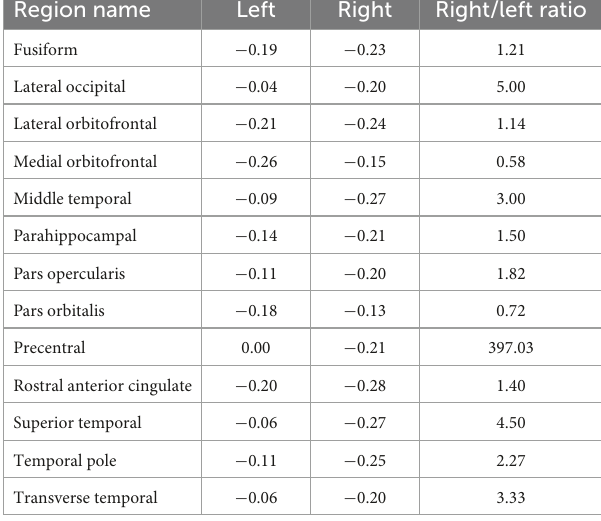
TABLE 2 R -values of the left and right hemispheres and the right/left asymmetry ratio for each region showing significant correlation between alpha peak amplitude and depressive score on either